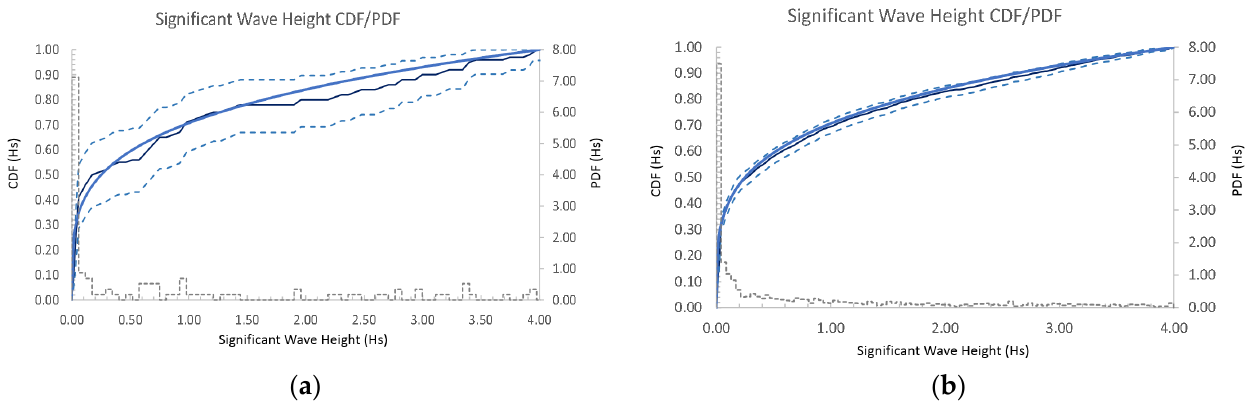
Figure 10. Confidence intervals: ( a ) 100 samples; ( b ) 1500 samples .